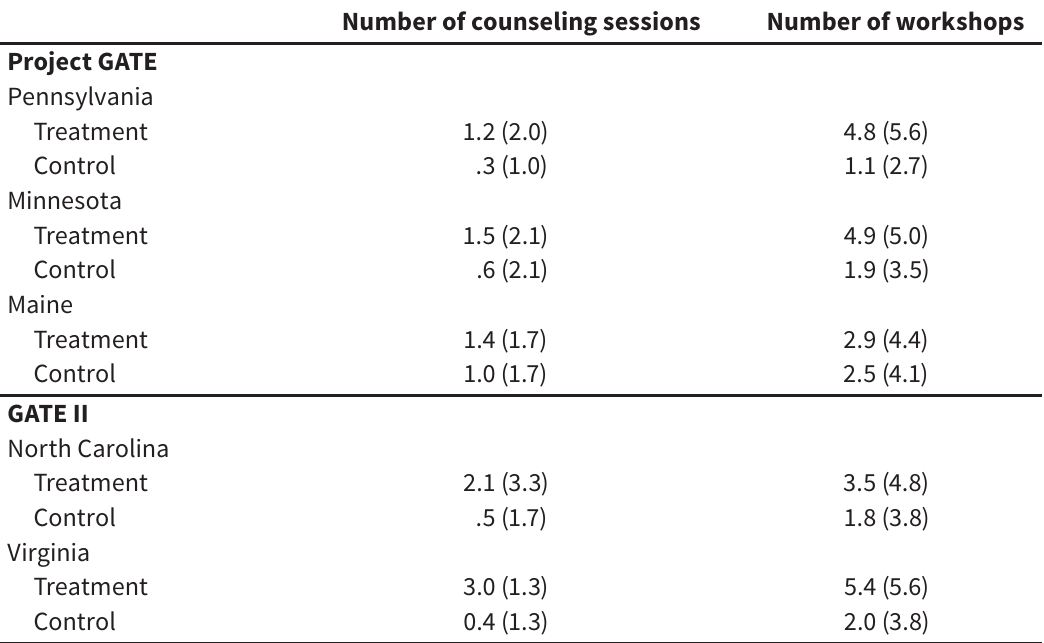
Number of completed counseling sessions and